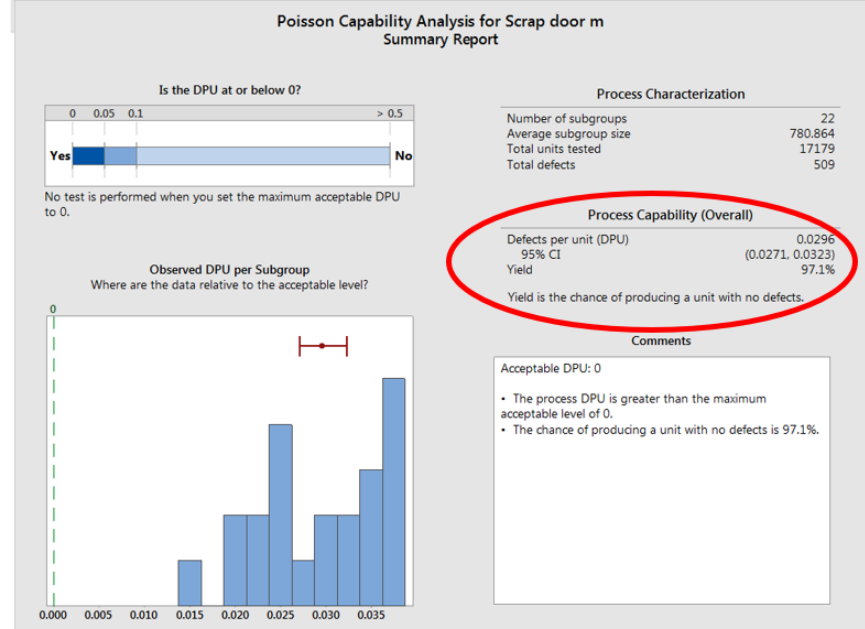
Figure 11. Poisson capability analysis for scrap door—DPU identi fi cation.